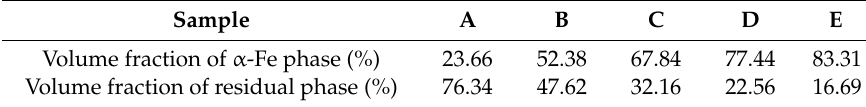
Table 3. Volume fraction of α -Fe phase in different samples.